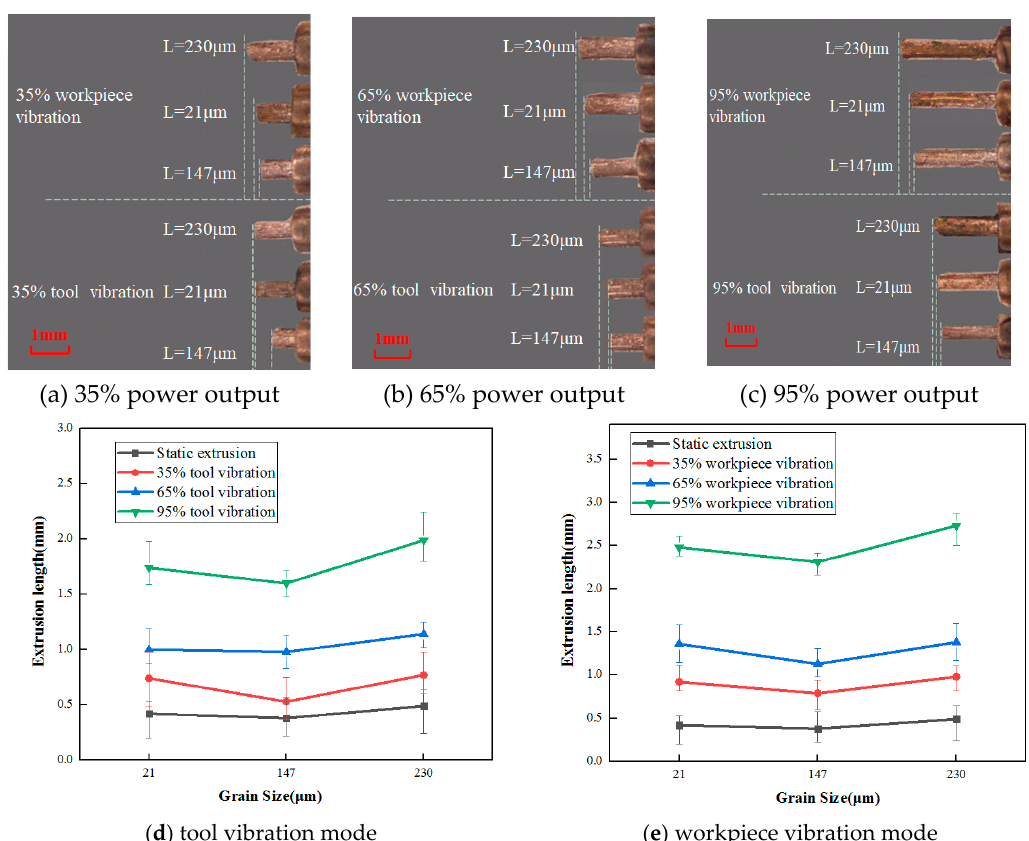
Figure 9. True stress and true strains with different initial grain sizes.